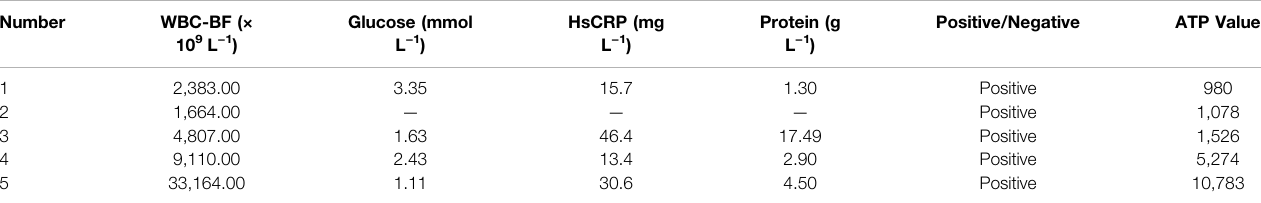
TABLE 1 | Data on CSF samples from fi ve patients with con fi rmed postoperative intracranial infection.